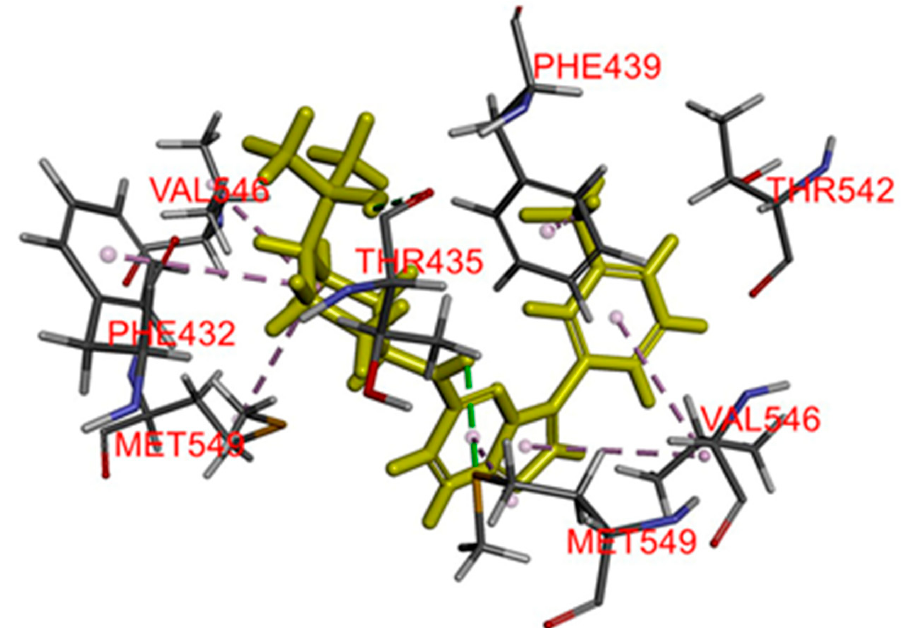
Figure 5. The binding mode of TP-3654 with ABCG2 protein structure (PDB:6VXH) was predicted by Accelrys Discovery Studio 4.0 software as described in Section 4. TP-3654 is shown as a molecular model with highlighted yellow color and the atoms for interacting amino acid residues were colored as carbon (gray), oxygen (red), hydrogen (light gray), and nitrogen (blue). Dotted lines indicate proposed interactions.